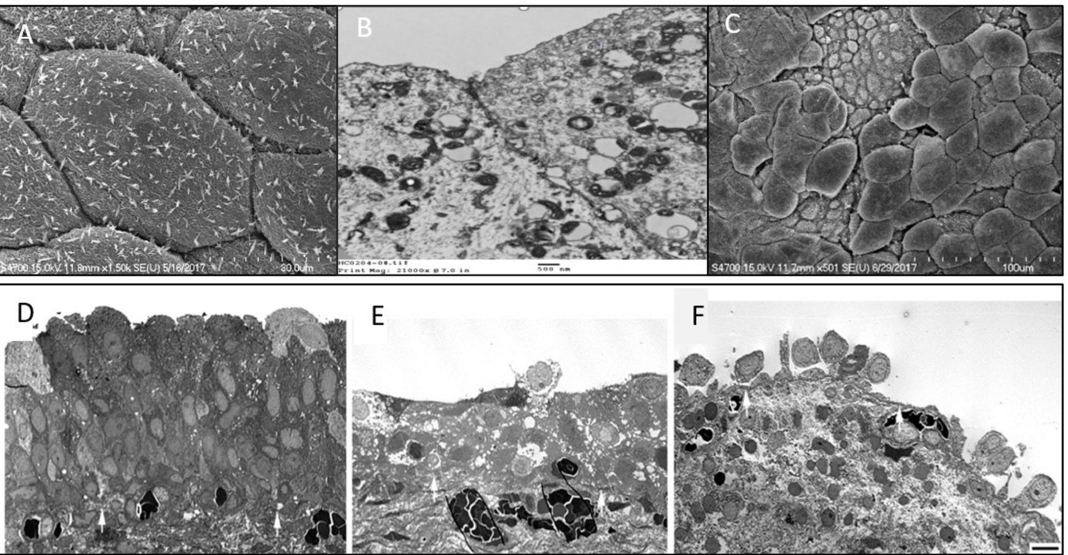
Figure 2. Scanning electron micrographs (EM) of the urothelium cell layer in ( A ) normal bladder urothelial cell integrity, ( B ) transmission EM showing normal tight junction of umbrella cells, ( C ) in- terstitial cystitis/bladder pain syndrome (IC/BPS) bladder showing defective urothelial cell layer and loss of the integrity of apical umbrella cells. Transmission EM of ( D ) normal bladder and ( E , F ) blad- ders with IC/BPS, showing different degrees of deficient urothelial cell layers and loss of the integrity of umbrella